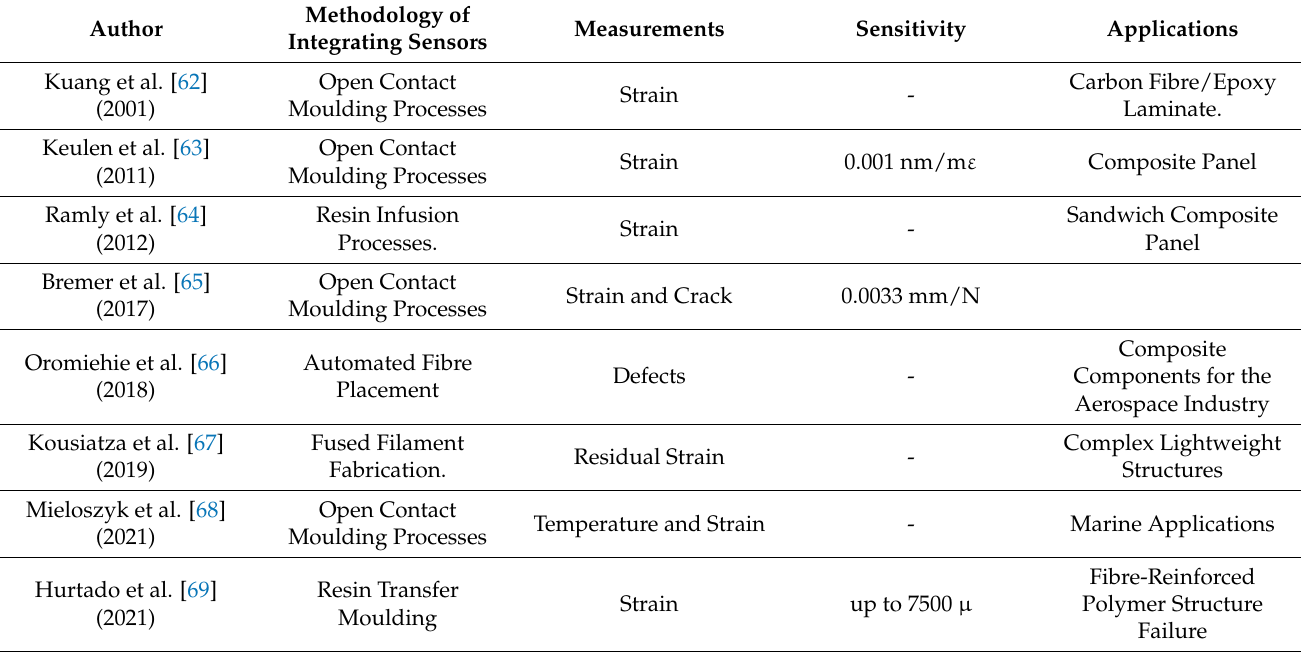
Table 2. Overview of applications and methodology of integrating Fibre Bragg grating (FBG) Sensors for composite structural components.